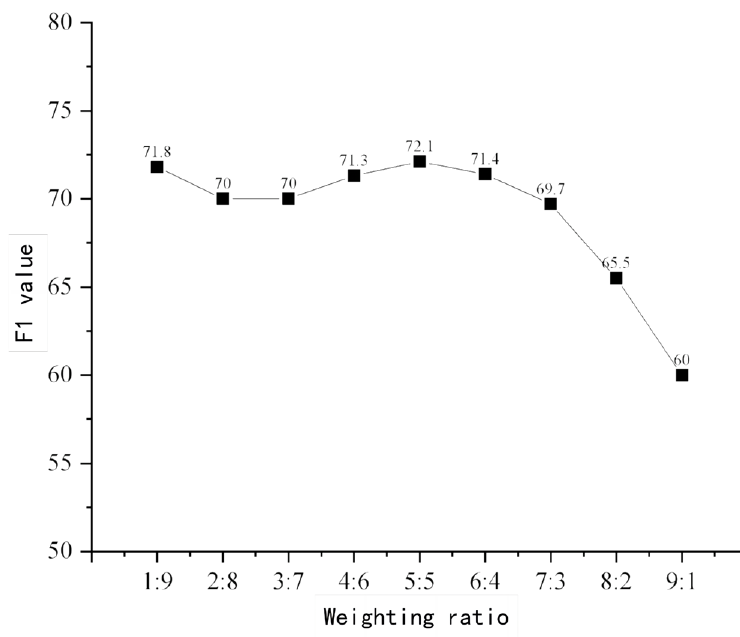
Figure 2. Variation of F1 values in relation to subtask weighting ratio. Table 9. Comparison of experimental results of fixed weighting and two kinds of dynamic weighting (%).